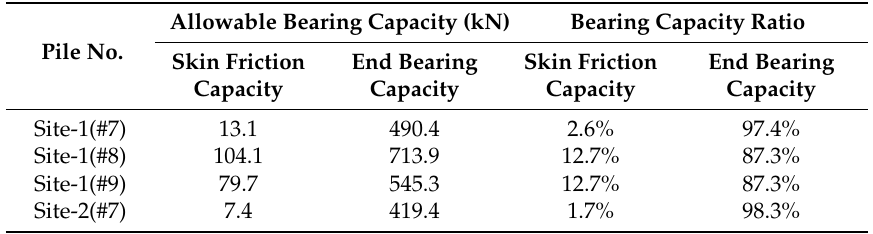
Table 5. Ratio of skin friction to end bearing capacity according to dynamic pile load test results.